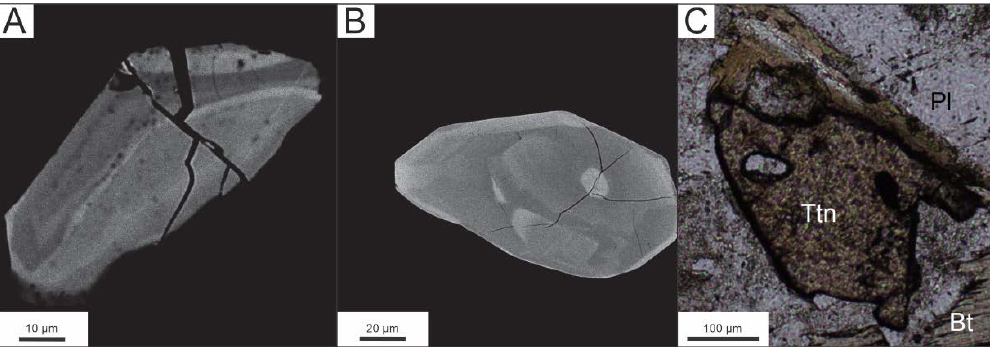
Figure 2. Images of zircon and titanite: ( A ) and ( B ) SEM-BSE images of zircon collected from diorite with gamma adjusted to highlight zoning (both grains from sample collected from drill core SB0806 at 69 m). ( C ) Transmitted light image of magmatic titanite grain used for geochronology (sample collected from drill core SB0806 at 63.7m).